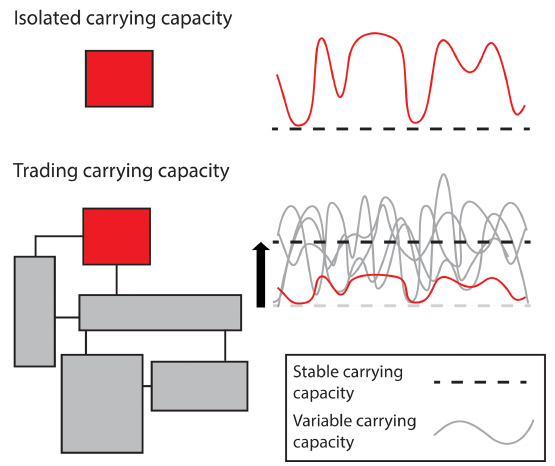
Figure 8. Conceptual figure illustrating the impact of trade on carry- ing capacity in a variable environment. Carrying capacities are vari- able over time owing to the impact of interannual climate variability on yields. In an isolated society populations must remain below the climate-forced carrying capacity to avoid famine. In societies with trade, the carrying capacity becomes the average carrying capacity of all trading regions. Thus, where there is a sufficient number of trading regions with heterogeneous environments, carrying capacity is increased without an increase in resource use in any of the trading societies. Trade even allows certain regions to attain carrying capac- ities well above their local ecohydrological constraints, thus facil- itating urbanization. However, under continued population growth, the resilience to climate variability provided by trade is eroded as populations approach a new global carrying capacity. In addition, urbanization means that regions become vulnerable to perturbations in the trade network as well as perturbations arising from crop fail- ure. Carrying capacities are smoothed to illustrate the dampening effect of food